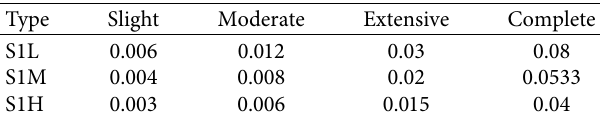
Table 3: Interstory Drift ratio in 4 failure modes according to HAZUS.